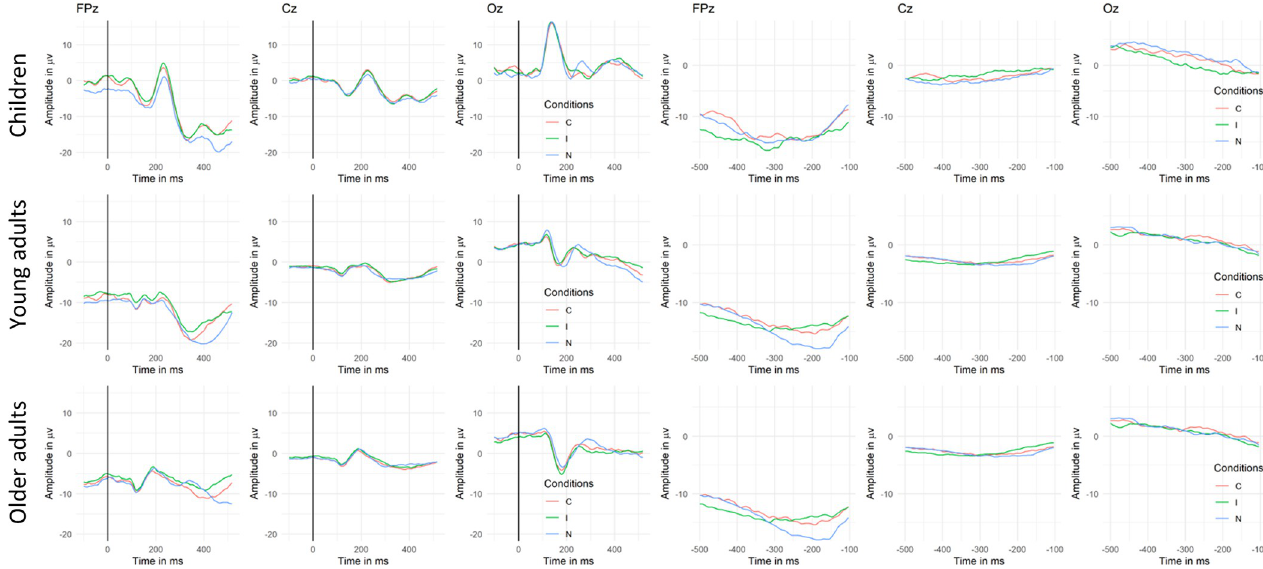
Fig 2. Exemplar waveforms of the grand averages of stimulus- and response-aligned ERP signal for the three conditions (C = congruent; I = incongruent; N = neutral) in each age group for the FPz, Cz and Oz electrodes. The peak analysis was also performed on the Fz and Pz electrodes. The gray rectangles shows the time window considered in the peak analysis (300 –